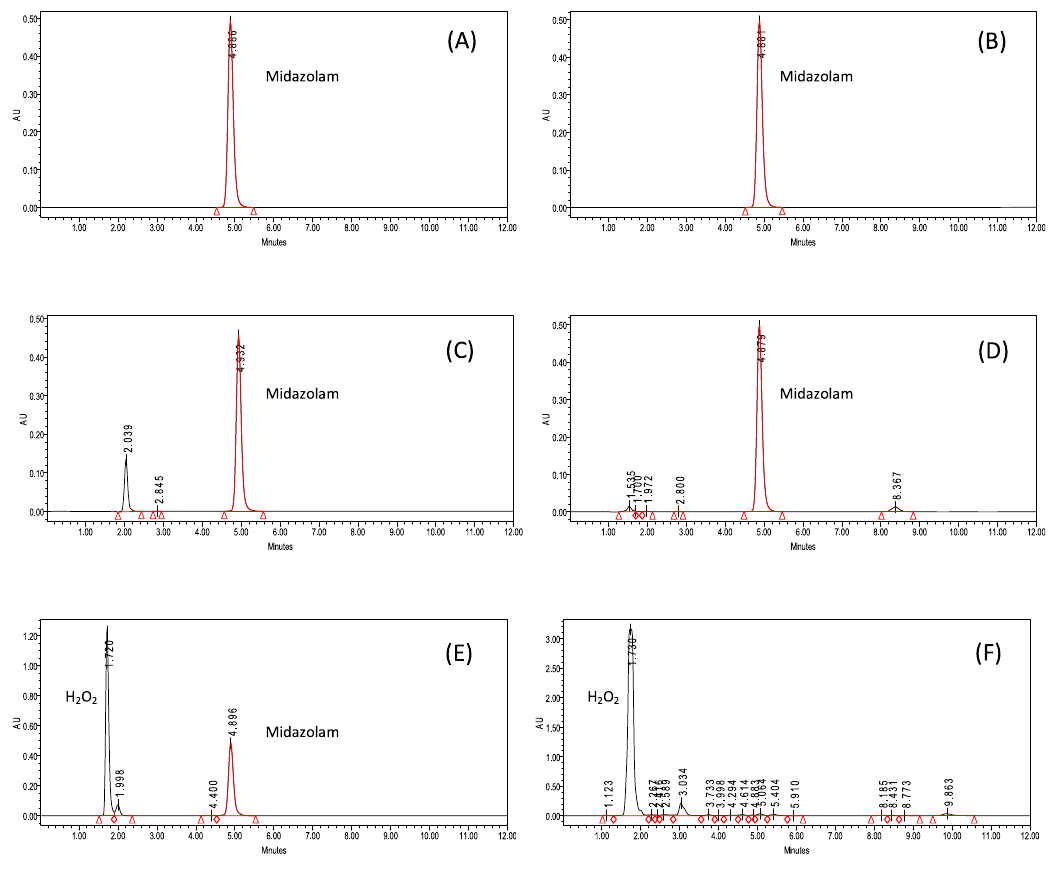
Figure 2: Representative HPLC-UV chromatograms of a reference midazolam hydrochloride solution at 200 μ g/mL (A) and after stressed conditions for 3 h: heat (B), HCl 1 M (C), NaOH 1 M (D), H 2 O 2 3% (E) and H 2 O 2 30%